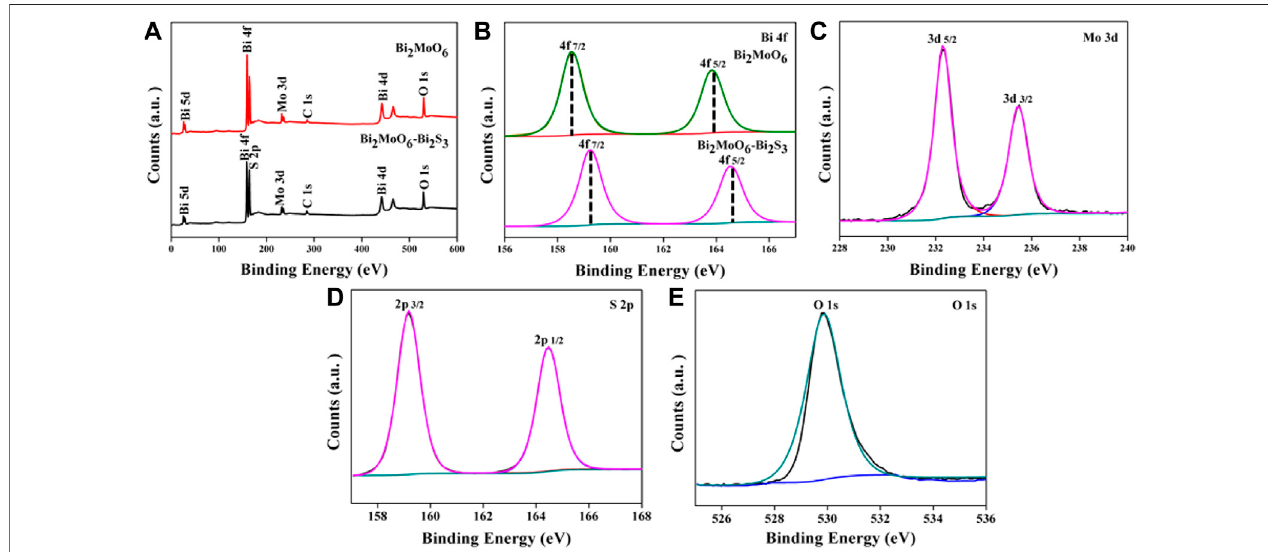
FIGURE 2 | XPS survey spectra of Bi 2 MoO 6 before and after reacting with L-Cys (A) ; high-resolution XPS spectra of Bi 4f (B) , Mo 3d (C) , S 2p (D) , and O 1s (E) .